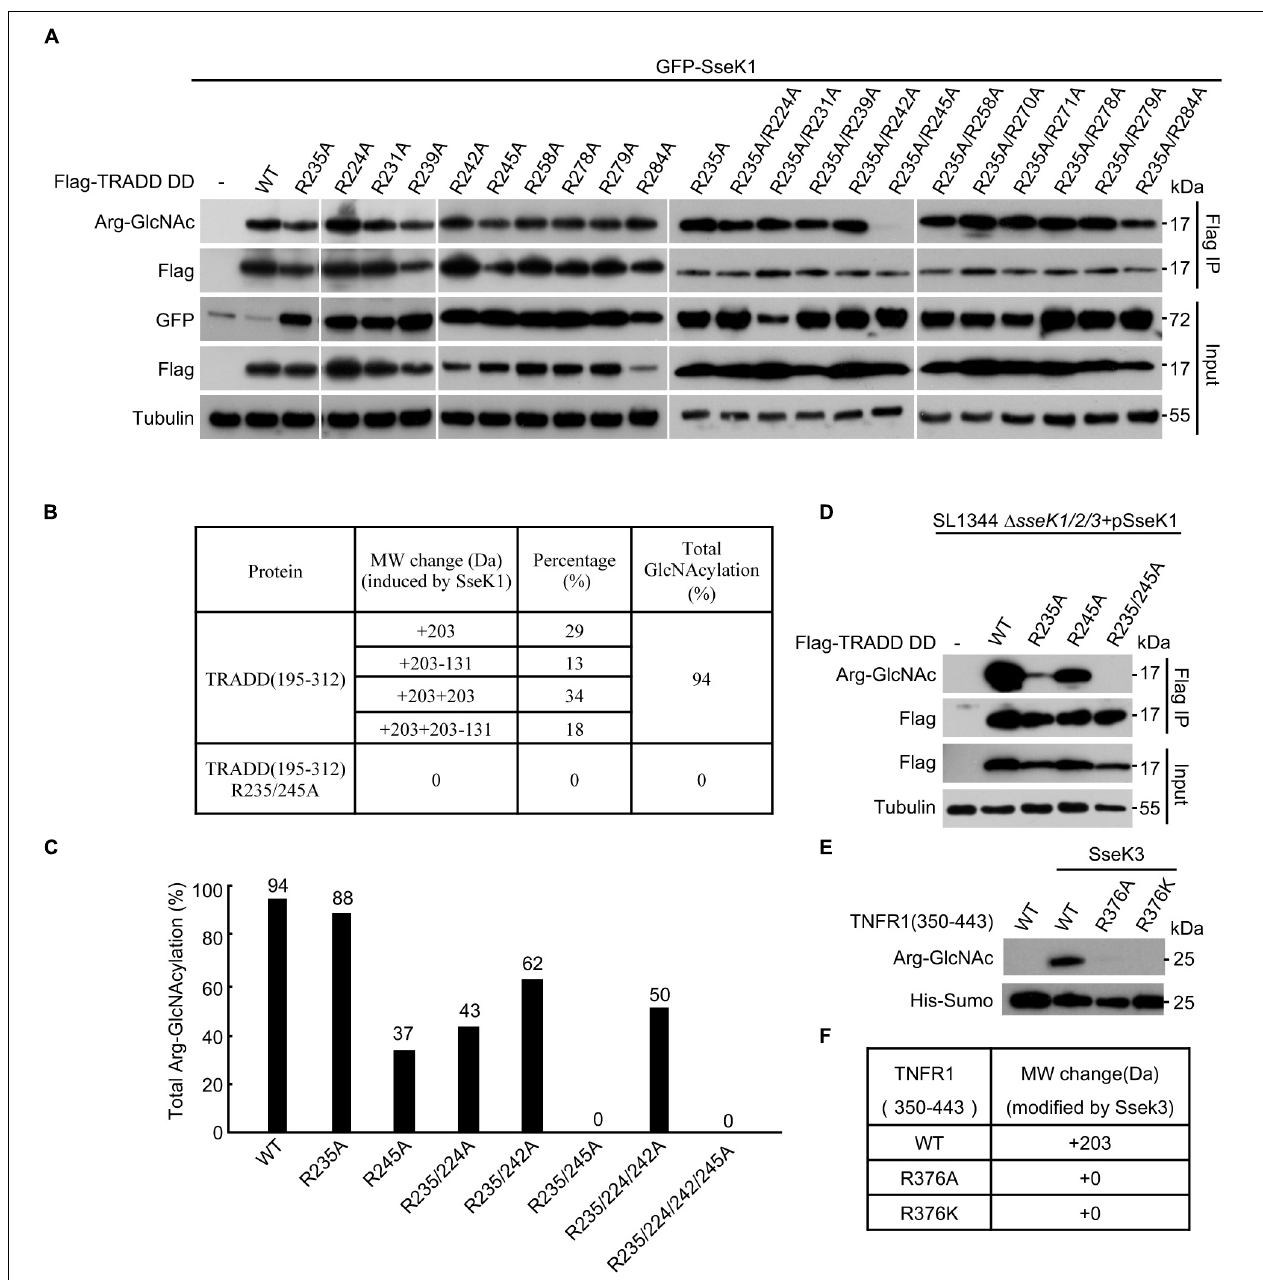
FIGURE 2 | SseK1 GlcNAcylates hTRADD at R235/R245and SseK3 GlcNAcylates TNFR1 at R376. (A) An arginine point mutation screen of hTRADD to investigate its ability to be GlcNAcylated by SseK1. 293T cells were transfected with the indicated plasmid combinations. The samples of anti-Flag immunoprecipitates (Flag IP) and total cell lysates (Input) were immunoblotted with the corresponding antibodies. Anti-tubulin was used as a loading control. (B) Mass spectrometry summary of the total molecular weight of TRADD DD and TRADD DD (Arg235Ala/Arg245Ala) mutant co-expressed with SseK1 in bacteria. “ + 203” indicates a single GlcNAc modification. “ + 203-131” indicates in addition to a single GlcNAc modification, one methionine is missing as well. “ + 203 + 203” indicates two GlcNAc modifications. “ + 203 + 203-131” indicates in addition to two GlcNAc modifications, one methionine is missing as well. (C) Total Arg-GlcNAcylation modification percentages of TRADD and TRADD arginine mutants catalyzed by SseK1. (D) Modification of TRADD and TRADD variants by SseK1 upon S. Typhimurium infection. Plasmids carrying genes for Flag-TRADD DD, Flag-TRADD DD R235A, Flag-TRADD DD R245A, and Flag-TRADD DD R235/245A transfected into 293T cells were infected with the indicated Salmonella strains. After infection, cells were lysed and proteins were immunoprecipitated with Flag beads, followed by standard immunoblotting analysis with the indicated antibodies. (E) TNFR1 WT and Arg376 mutants co-expressed with SseK3 in BL21. Bacterial lysates were subjected to SDS-PAGE, followed by immunoblotting analyses as shown. (F) Summary of ESI-MS determination of the total mass of TNFR1 and its mutants co-expressed with SseK3 in bacteria. Data in (A–D) are from at least three independent experiments.